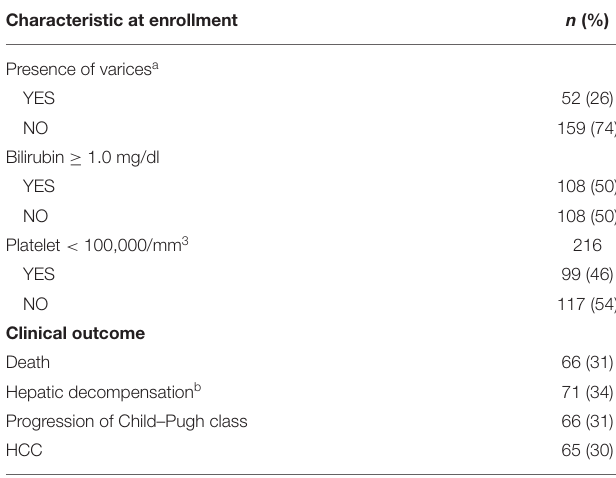
TABLE 1 | Clinical features of 216 hepatitis C–related early-stage cirrhosis